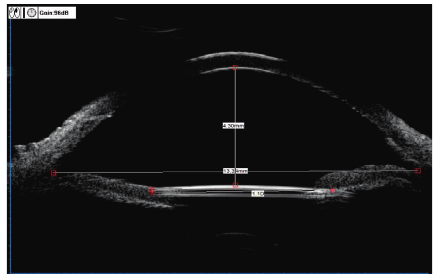
Figure 7: Anterior chamber depth measured by